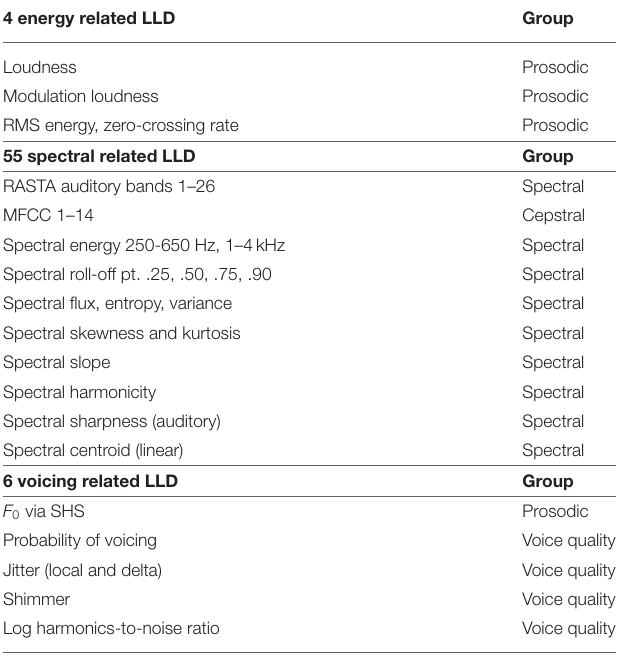
TABLE 2 | Interspeech 2013 Computational Paralinguistics Challenge feature